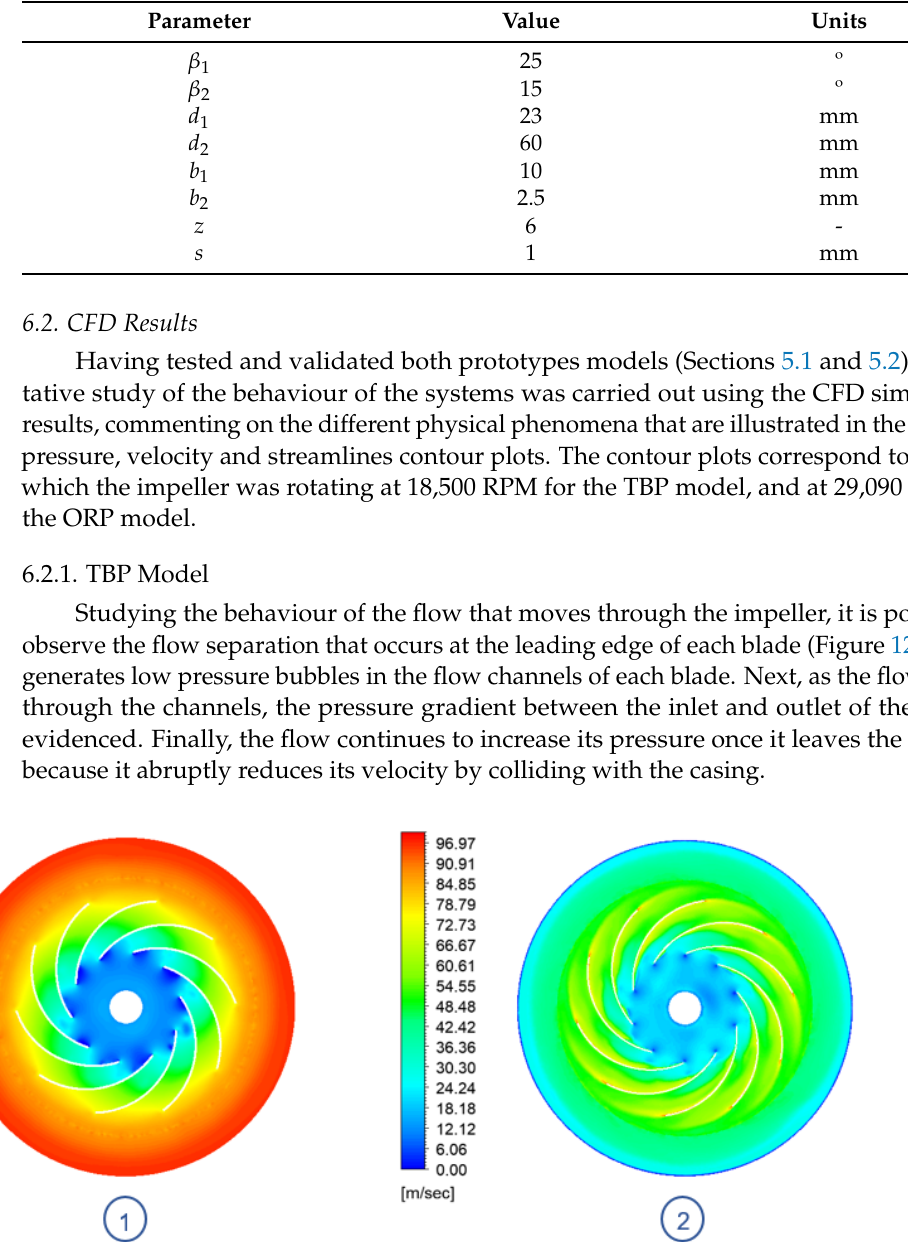
Table 12. Main dimensions of the ORP impeller.